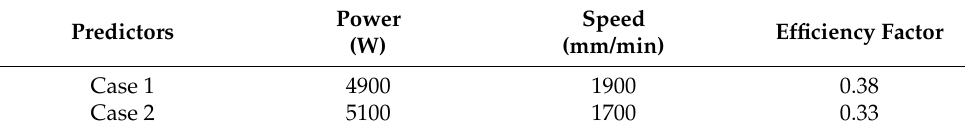
Table 15. Efficiency factor